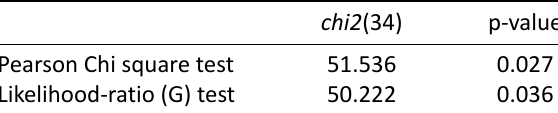
Table 5. Test of interdependence for choice of holiday destination and residence in the capital city